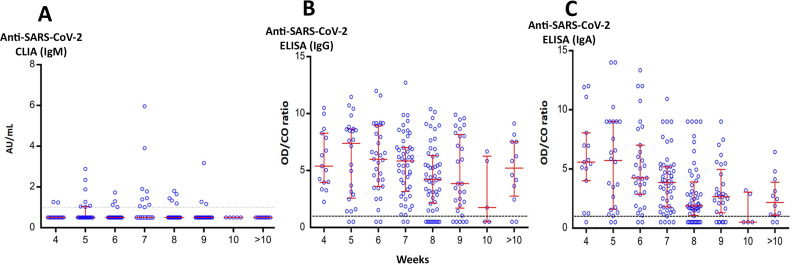
Antibodies against SARS-CoV-2 in recovered COVID-19 cases.IgM (A), IgG (B), and IgA (C) antibody levels were stratified according to the number of weeks between the day of symptom onset and the day of sample collection. Horizontal lines represent the upper and lower interquartile range (IQR) and the median value.